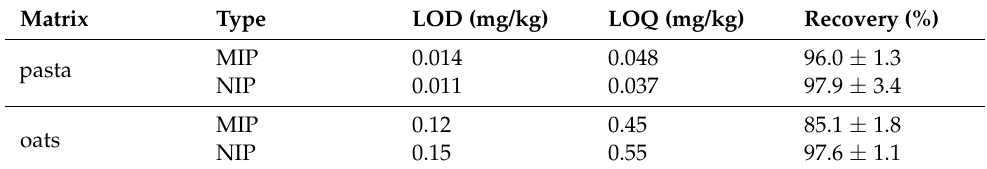
Table 5. LOD and LOQ derived for CIT quantification by MISPE using core-shell MIP imprinted by RHO (matrix-matched five-point calibration following DIN 32645, recovery as mean ± RSD, n = 3). Matrix Type LOD (mg/kg) LOQ